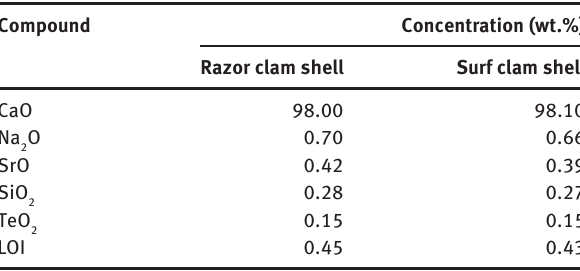
Table 1: Chemical compositions of waste shell-derived catalyst. Compound Concentration